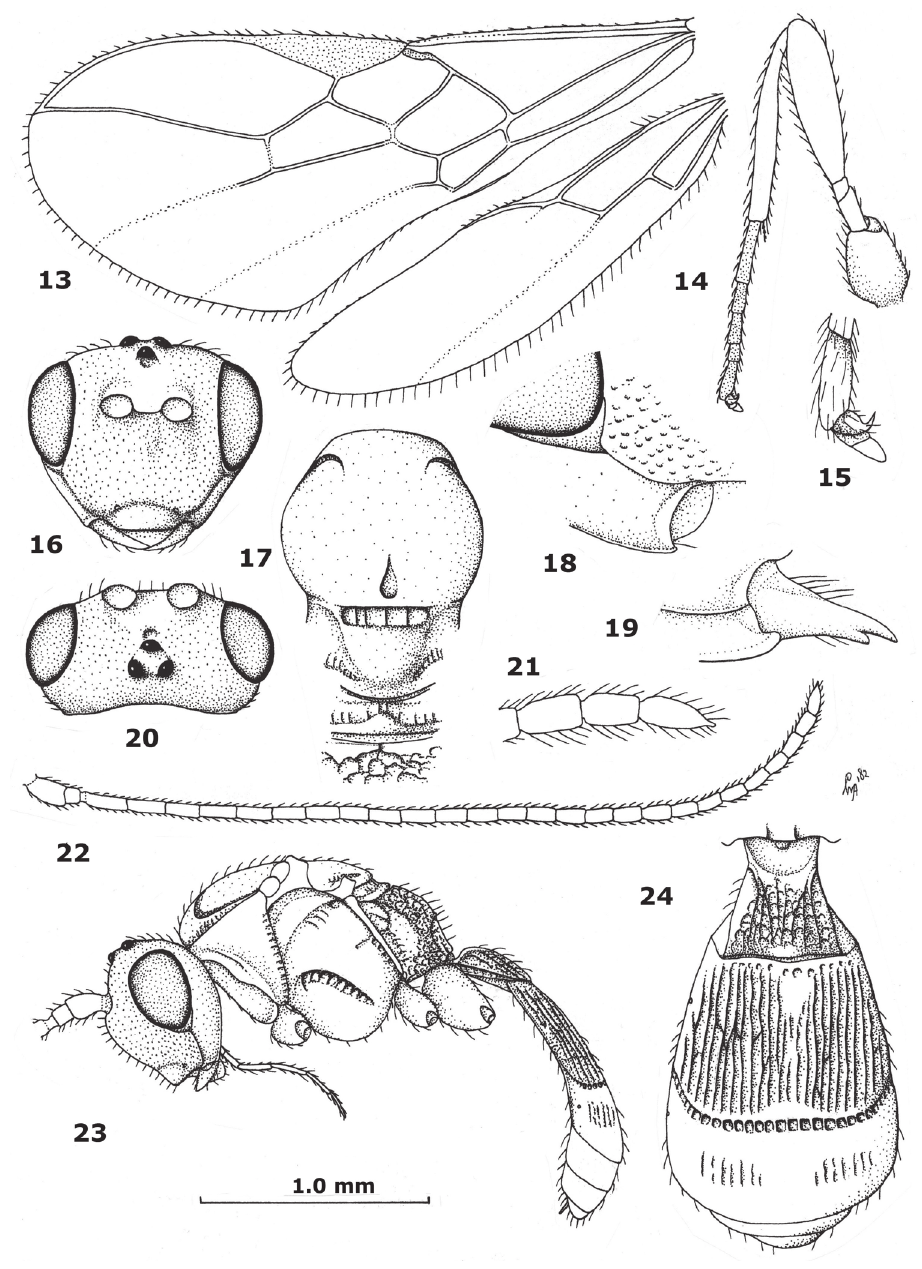
Figures 13–24. Orientopius curiosigaster Fischer, male, holotype. 13 wings 14 hind leg 15 outer hind claw 16 head anterior 17 mesosoma dorsal 18 malar space 19 mandible and ventral part of occipital carina 20 head dorsal 21 apex of antenna 22 antenna 23 habitus lateral 24 metasoma dorsal. 13, 14, 22, 23 : scale-line (= 1 x); 15 : 5 ×; 16, 17, 20, 24 : 1.3 ×; 18, 19, 21 : 2.5